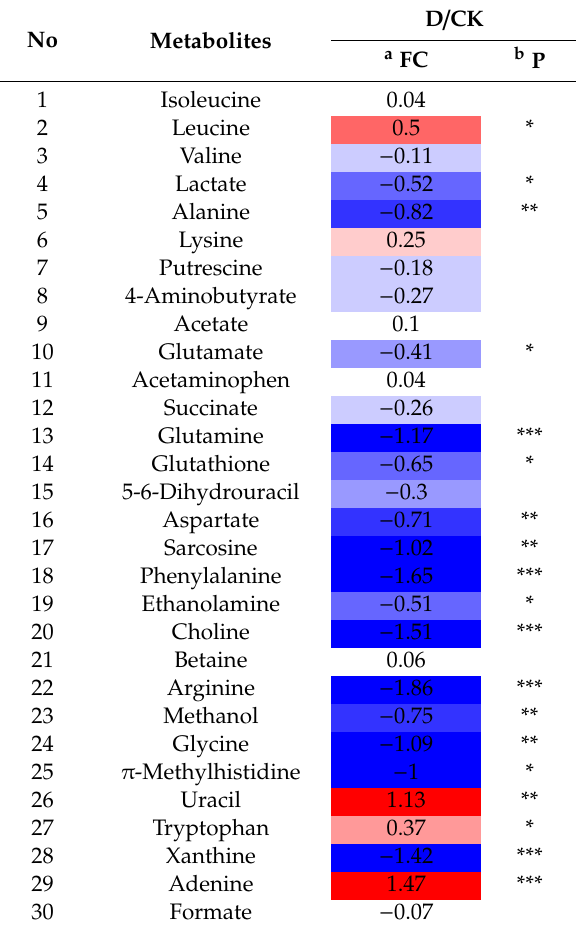
a FC:Color-codedaccordingtothefold-changevalue; Colorcodedaccordingtothelog and blue represents decreased concentrations of metabolites. Color bar